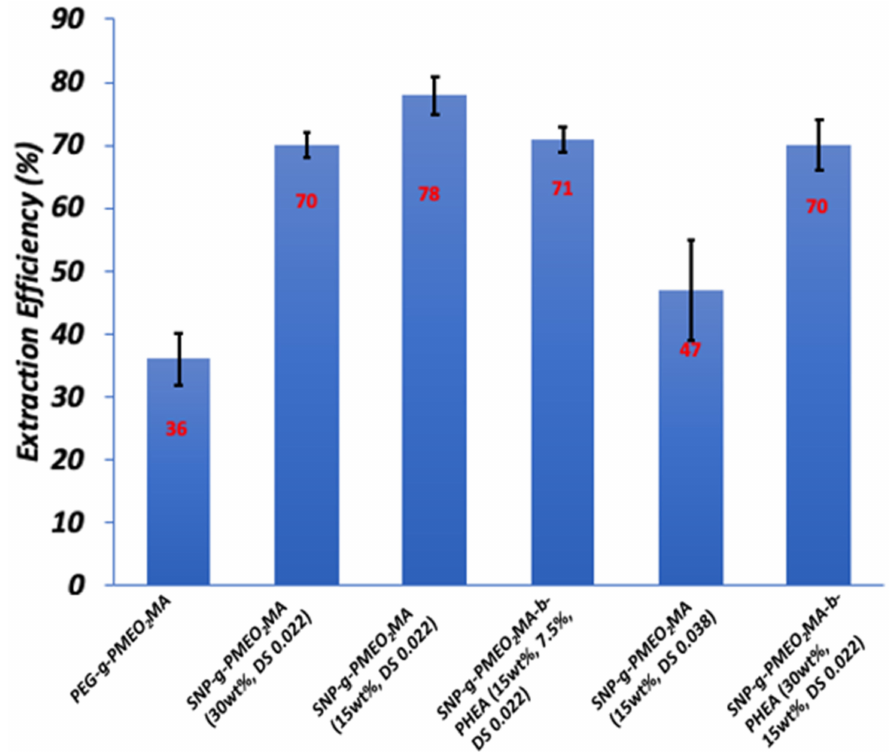
Figure 10. Bitumen extraction efficiency with 15 mg of polymer-grafted SNPs, 0.5 M NaCl, 15 mL of water, and 60 mg of toluene at 45 ◦ C for various polymer-grafted SNP